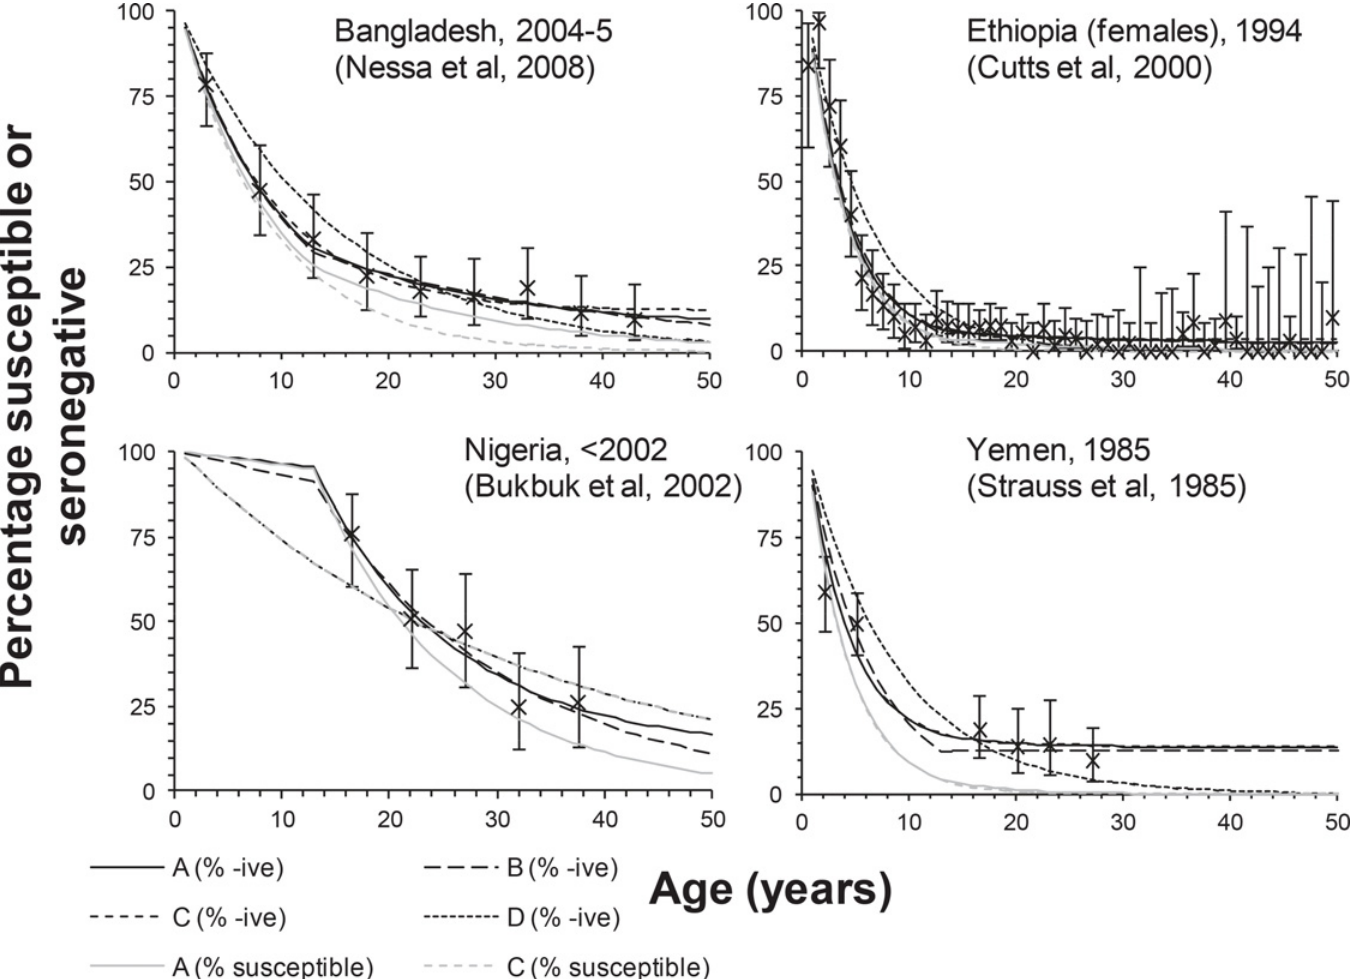
Fig 2. Examples of the fit of catalytic models to the data sets. Comparison between model predictions of the percentage susceptible and the percentage seronegative to rubella obtained using the four types of catalytic model (denoted by the lines labelled A, B, C and D), and that observed in various settings. The crosses show the observed percentage seronegative together with 95% (exact) confidence